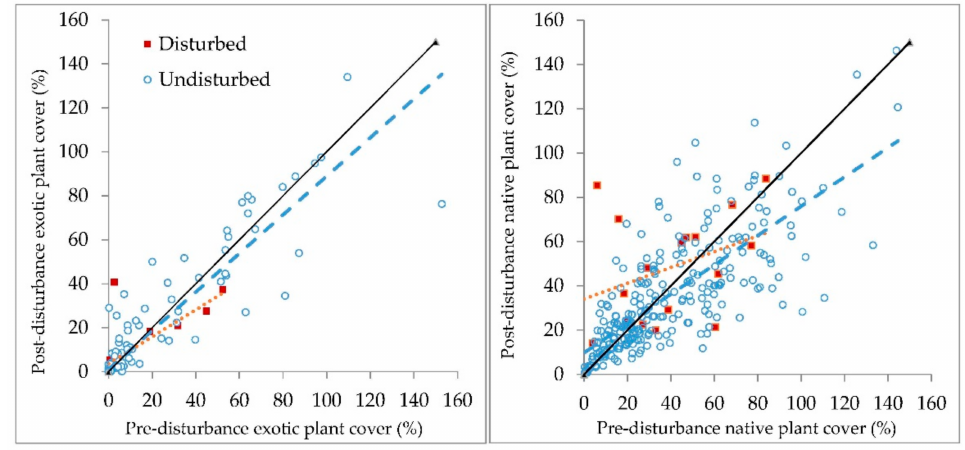
Figure 4. Regression analysis of the average cover (%) of exotic plants ( left panel ) in disturbed, dotted line ( n = 18, y = 0.61 x + 3.6, R 2 = 0.56), and undisturbed, dashed line ( n = 262, y = 0.88 x + 1.13, R 2 = 0.85), plots before and after the disturbance events. Regression analysis of the average cover (%) of native plants ( right panel ) in disturbed ( n = 18, y = 0.36 x + 34.0, R 2 = 0.13) and undisturbed plots ( n = 262, y = 0.66 x + 9.8, R 2 = 0.57) before and after the disturbance events. Solid line illustrates a slope of one and represents no change between sampling periods. Note that many of the disturbed plots had low exotic plant cover before and after the disturbance events and are therefore obscured among the abundant undisturbed plots also grouped